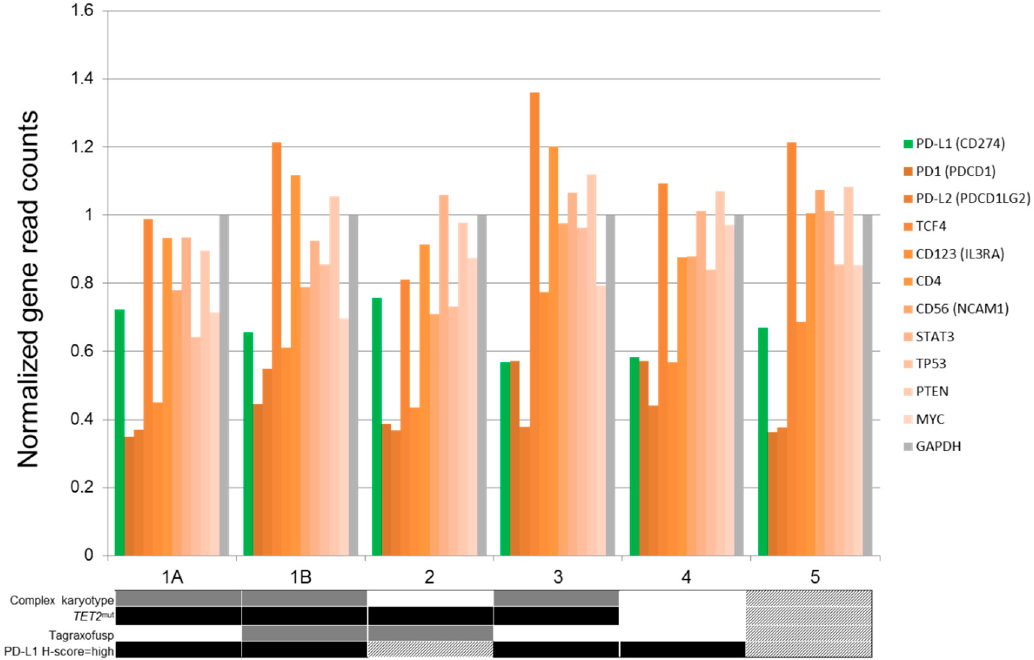
Figure 4. Normalized mRNA gene read counts (variance stabilizing transformation) relative to GAPDH of PD-L1 (CD274) and related transcripts of known significance in the PD1 / PD-L1 axis. Samples 1A and 1B are from the same patient, collected at baseline (pretherapy) and at relapse following tagraxofusp therapy. Corresponding clinical and laboratory data are depicted schematically as follows: solid gray or black boxes = positive; while white boxes = negative; shaded boxes = unavailable.